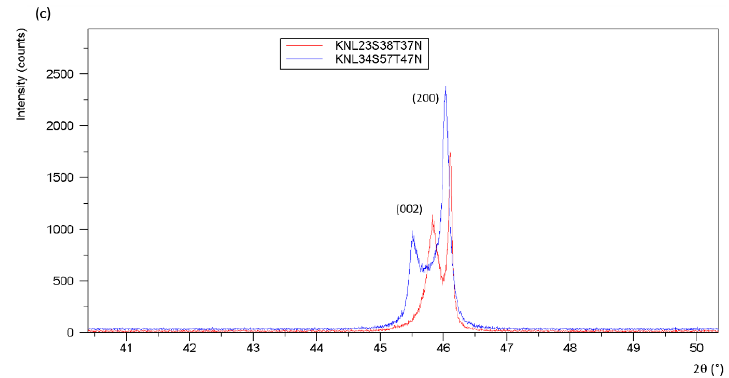
Figure 7. XRD patterns on crushed crystals of ( a ) KNL23S38T37N (attempt 4) and KNL34S57T47N (attempt 5) exhibiting tetragonal structure; ( b ) XRD patterns with an intensity logarithm scale where no inclusions are detected ( c ) and zoom on (200) and (002) lines for KNL23S38T37N and KNL34S57T47N.